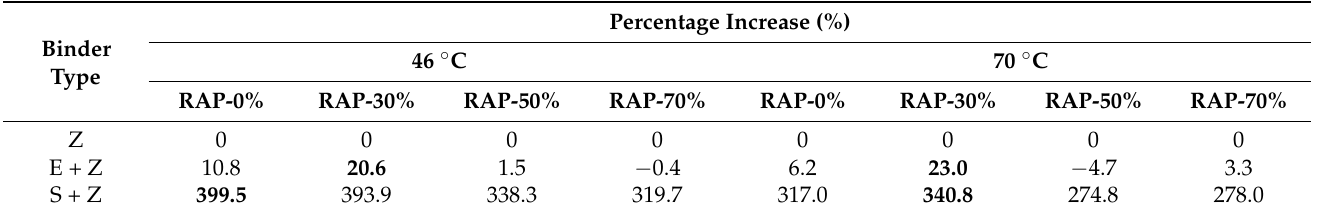
Table 6. Percentage increase in | G *|/sin δ caused by the WMA additive under the unaged